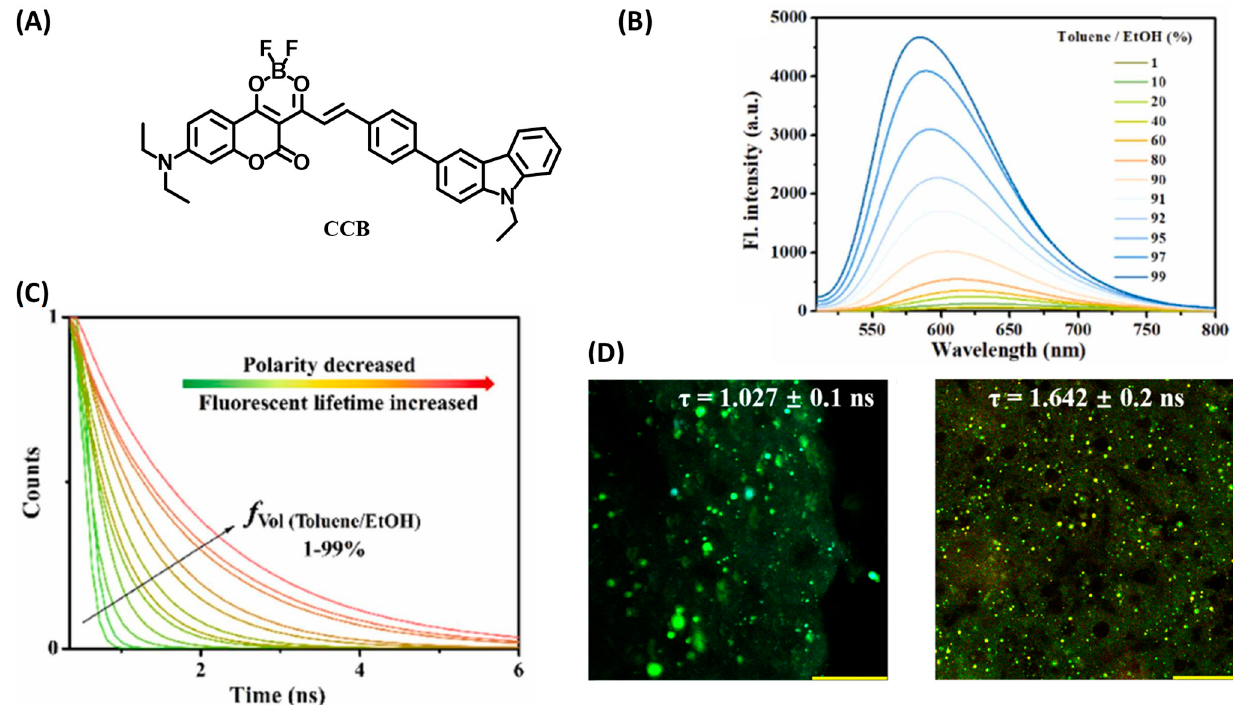
Figure 12. ( A ) Structure of CCB for lipid droplet tracking. ( B ) The fluorescent spectrum of the probe CCB (10 µ M) in various toluene/EtOH ratios. ( C ) Fluorescence decays of CCB (100 µ M) in various toluene/EtOH ratios. ( D ) FLIM images of the liver obtained from (left) normal mouse and (right) NAFLD mouse. Scale bar: 100 µ m [42]. Copyright © 2023 Elsevier B.V. All rights